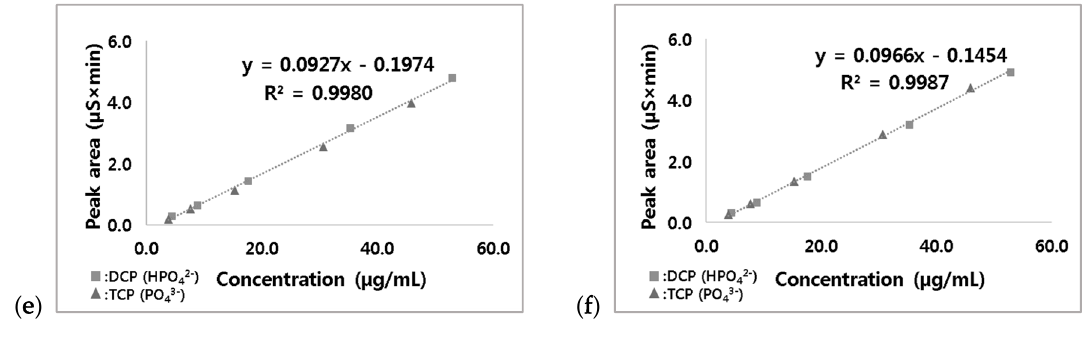
Figure 4. Matrix-based calibration curves: ( a ) DCP in snacks; ( b ) TCP in snacks; ( c ) DCP in cereals; ( d ) TCP in cereals; ( e ) DCP (HPO 42 − ) and TCP (PO 43 − ) in snacks; ( f ) DCP (HPO 42 − ) and TCP (PO 43 − ) in